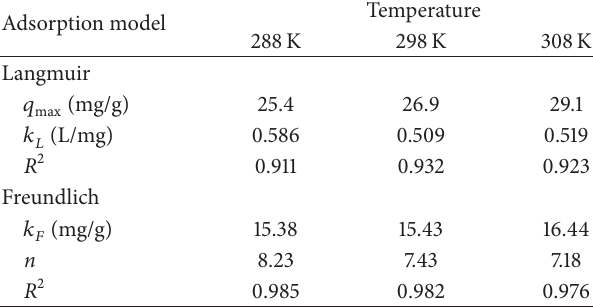
Table 2: Parameters of the Langmuir and Freundlich isotherm models for the adsorption of ORII onto the CTAB-modified corn- stalk